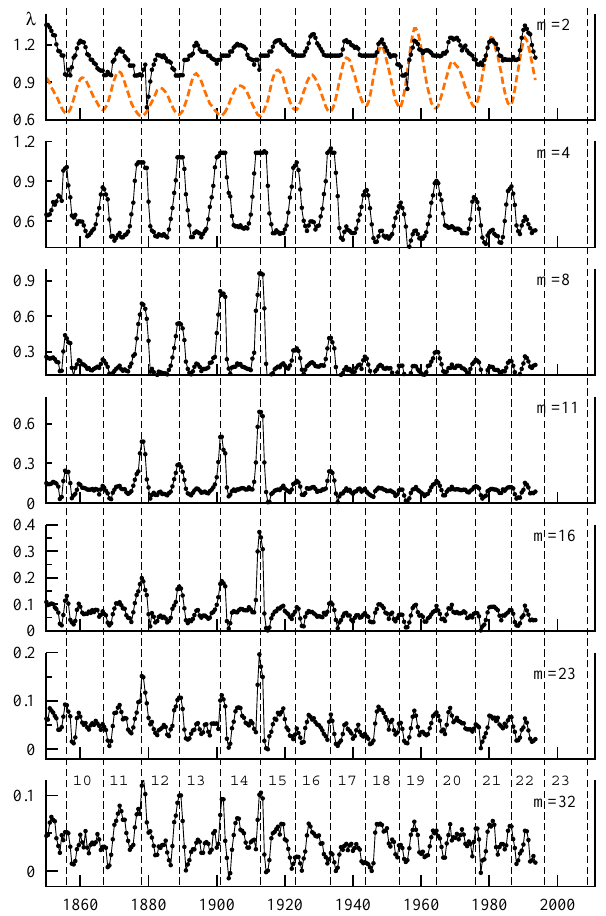
Figure B2. The irregularity index λ computed for GSN (Hoyt and Schatten, 1998) within 4-year sliding windows; the embedding di- mension m is indicated; vertical lines are at solar cycle